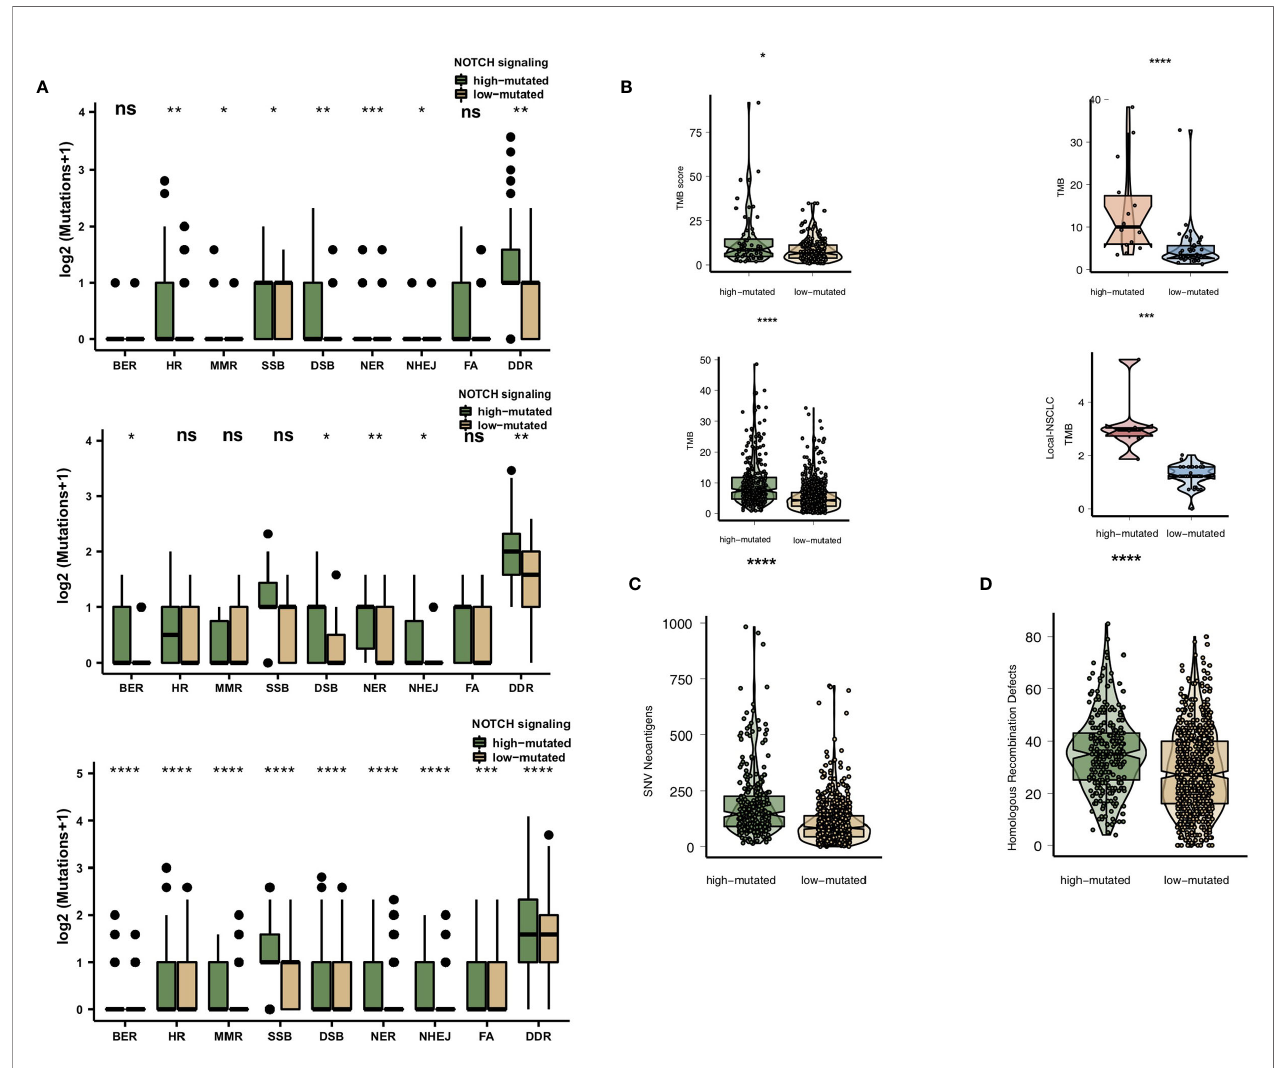
FIGURE 4 | (A) . Comparison of DNA damage-related gene set alterations between the high-mutated and low-mutated NOTCH groups in the MSKCC, NG and TCGA-NSCLC cohorts. (B) Comparison of the TMB between the high-mutated and low-mutated NOTCH groups in the MSKCC, NG, TCGA-NSCLC and Local cohorts. (C) Comparison of NAL between the high-mutated and low-mutated NOTCH groups in the TCGA-NSCLC cohort. (D) Comparison of the number of homologous recombination defects between the high-mutated and low-mutated NOTCH groups in the TCGA-NSCLC cohort. NSCLC, non-small cell lung cancer; TCGA, The Cancer Genome Atlas; TMB, tumor mutational burden; NAL, neoantigen load; FA, Fanconi anemia; HR, homologous recombination; NHEJ, nonhomologous end joining; BER, base excision repair; MMR, mismatch repair; NER, nucleotide excision repair; DSB, double-strand break; SSB, single-strand break. (*P < 0.05; **P < 0.01; ***P < 0.001; ****P < 0.0001; Mann-Whitney U test). NS, not signi fi